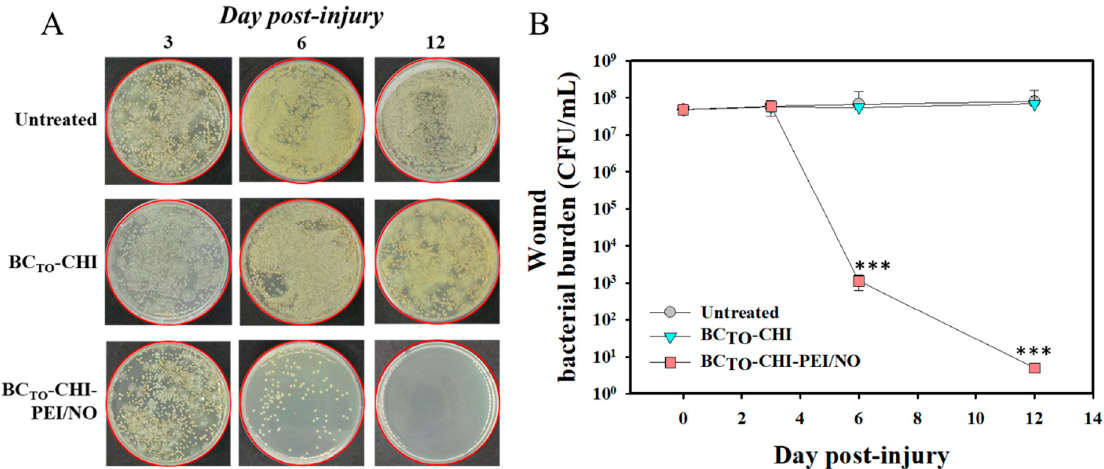
Figure 8. Bacterial burden in the wound. ( A ) Bacterial growth after plating of swab samples and wound tissues on tryptic soy broth (TSB) or Luria-Bertani (LB) agar at day 3, 6, and 12 post-injury. ( B ) Viable counts of bacteria on wounds. Wounds were swabbed, and bacterial burden was examined. Data are presented as the mean ± standard deviation; n = 3. “***” indicates p < 0.001 compared to the untreated.